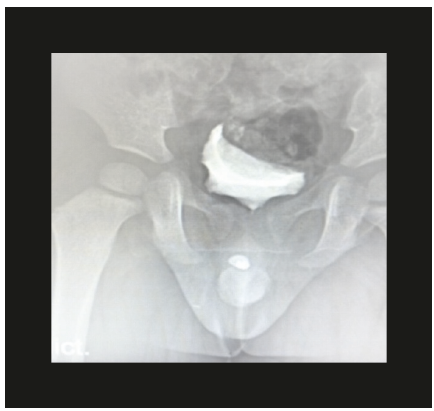
Figure 4: Postvoid residue on VCUG (case 1).